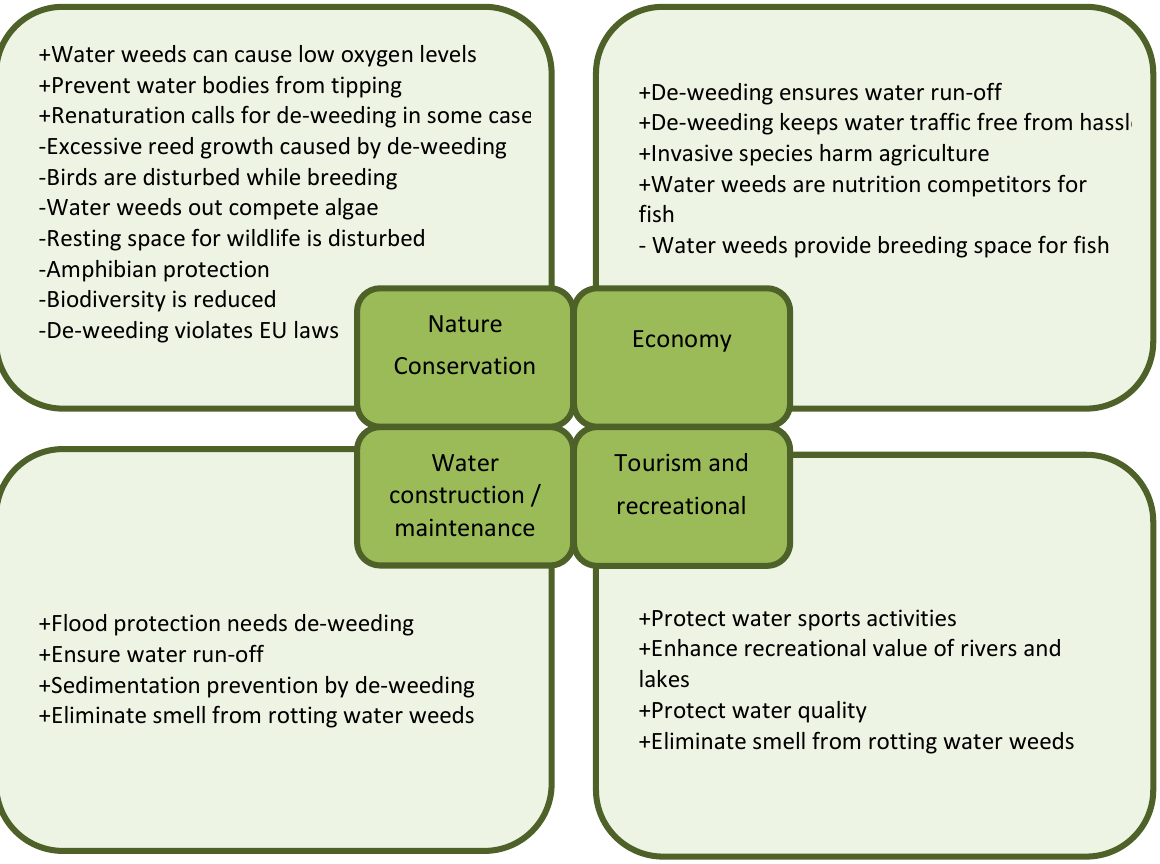
Figure 3: Arguments for (+) and against (-)